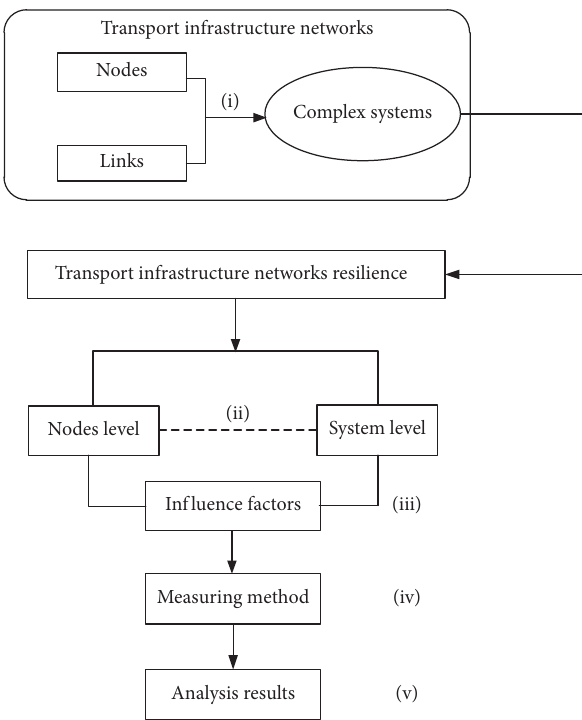
Figure 1: Assessment process of transport infrastructure networks